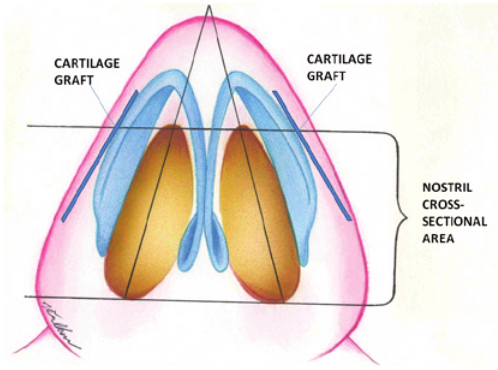
FIGURE 1 - Placement of cartilage grafts and nostril cross-sectional area (brown